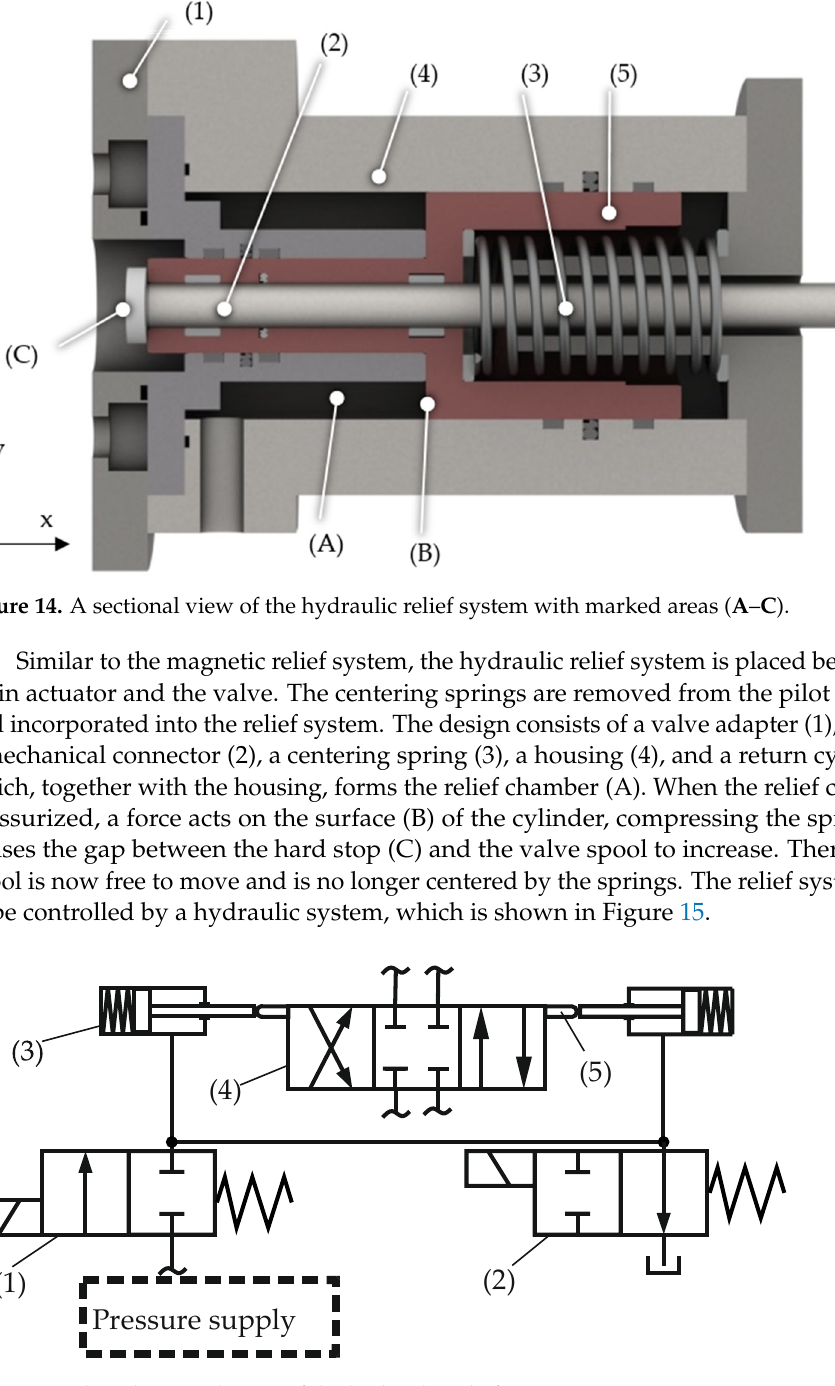
Figure 15. The schematic layout of the hydraulic relief system. The pressure supply of the circuit is not further defined, but since the relief system can be activated independently from the valve, it can be diverted from the main system during high-pressure phases or when the valve is closed. An additional hydraulic circuit can therefore be avoided. The relief system is depicted as a spring-returned cylinder (3), which acts on the valve (4) by means of a mechanical connection (5). The hydraulic relief is controlled by two poppet valves. During the loading process, the first valve (1) needs to be opened, while the second valve (2) must be closed. After the relief system is pressurized, both valves must be closed. Regardless of what happens in the hydraulic circuit, the pressure in the relief system will be kept constant. As valve (2) opens, the relief system